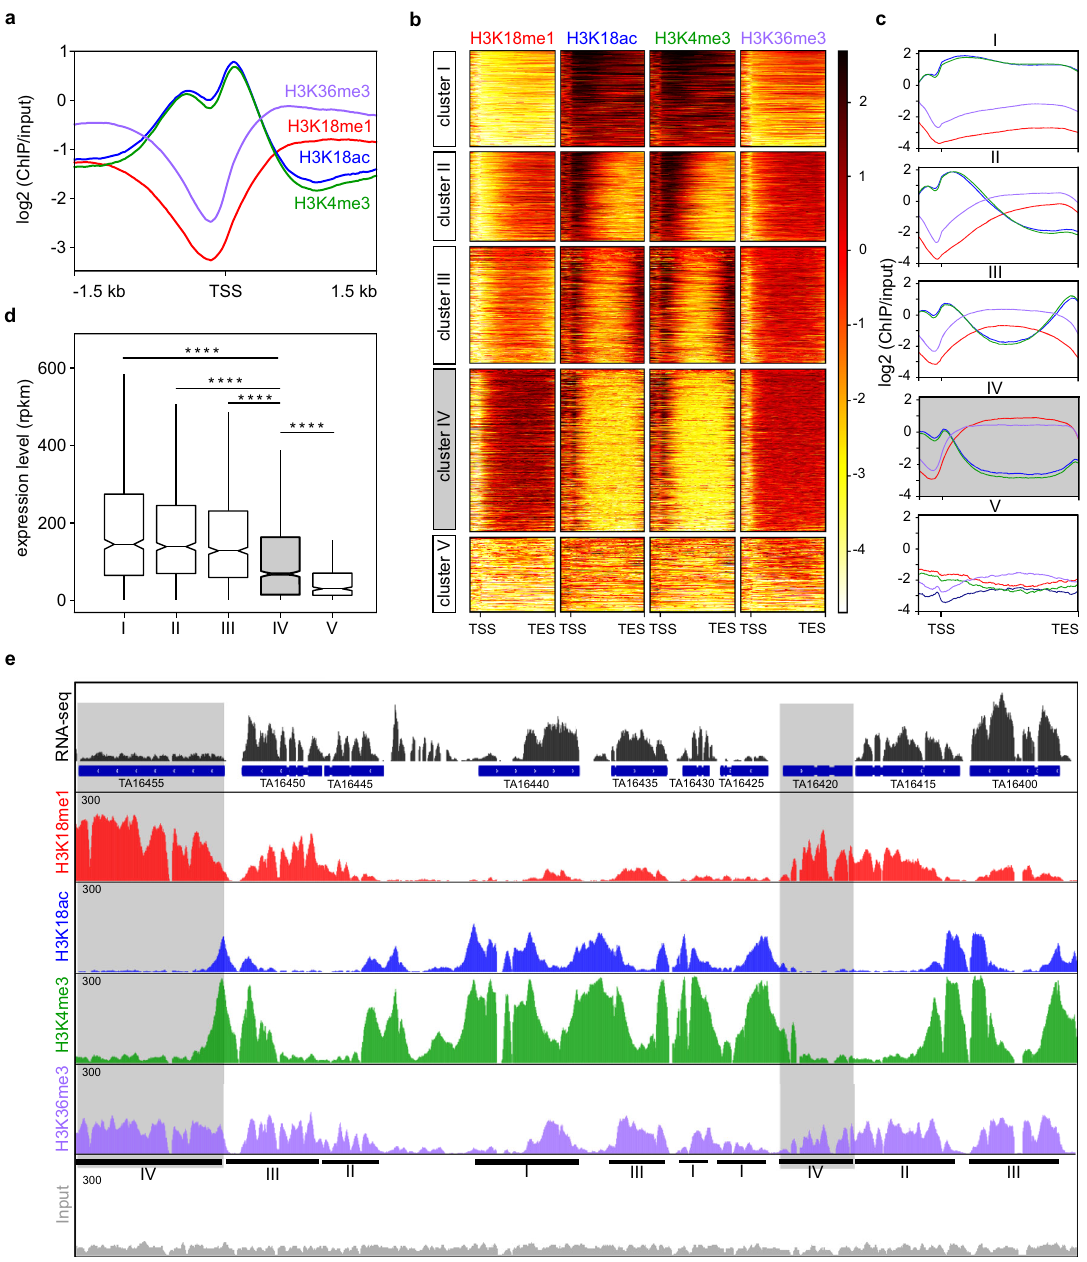
Fig. 2 Mono-methylation of H3K18 is distributed on the gene bodies of repressed genes. a Average occupancy pro fi les for H3K4me3 (green), H3K18ac (blue), H3K18me1 (red) and H3K36me3 (purple) around transcriptional start sites (TSS) of all T. annulata genes. X -axis: genomic coordinates ± 1.5 kb. Y -axis: log2 (ChIP/Input). b Heatmap of occupancy across all Theileria genes starting from 500 bp before the TSS to the end of the gene (TES), normalised by length (normalised to input read coverage). Clustering is the result of a 5 k-means clustering on H3K18me1. The H3K18me1-enriched Cluster IV is highlighted in light grey. c Average occupancy pro fi les per cluster for H3K4me3 (green), H3K18ac (blue), H3K18me1 (red) and H3K36me3 (purple) starting from 500 bp before the TSS to the TES, normalised by length. Cluster IV is highlighted in grey. d Boxplot of gene expression (RPKM) per cluster as de fi ned by the 5 k-means clusterings on H3K18me1. Pairwise-Wilcoxon statistical testing is indicated. Custer IV is highlighted in grey. Statistical test Dunnett ’ s multiple comparison test: **** p < 0.0001. A two-sided pairwise Wilcoxon test was performed. Values: ns: p > 0.05,* p < 0.05, ** p < 0.01,*** p < 0.001, **** p < 0.0001. Minimum and maximum are represented by upper and lower Whiskers, respectively. Interquartile representation includes fi rst and third quartile, centre representing median, test was performed on three RNA-Seq replicates. e Selected genome region depicting epigenetic pro fi les and gene expression for Theileria genes belonging to the four clusters (indicated below). Two genes from cluster IV are highlighted in grey ( TA16455 , TA16420 ). H3K4me3 (green), H3K18ac (blue), H3K18me1 (red) and H3K36me3 (purple), Input (grey). The region ranges from gene TA16455 to TA16400 ,